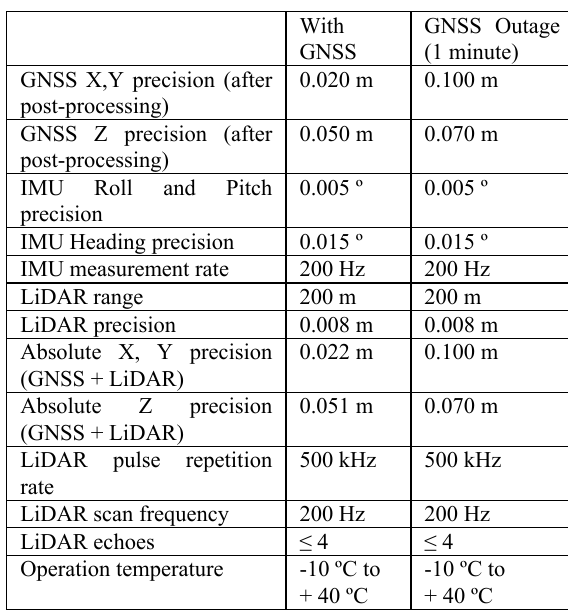
Table 1. Technical specifications of Optech Lynx Mobile Mapper.